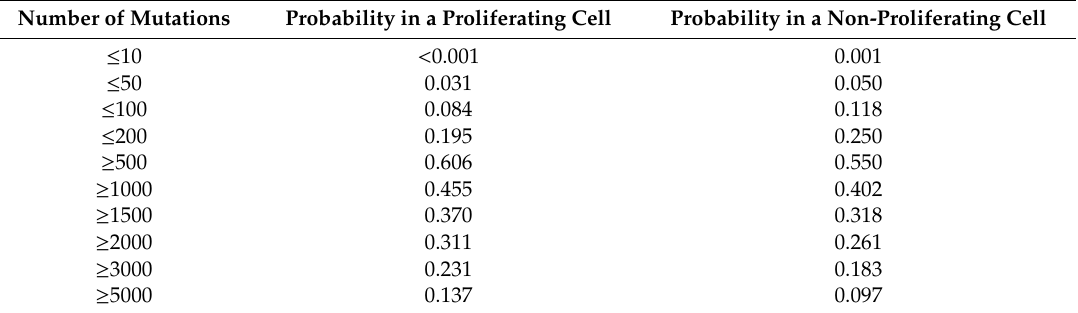
Table 1. Probability of a given number of mutations per